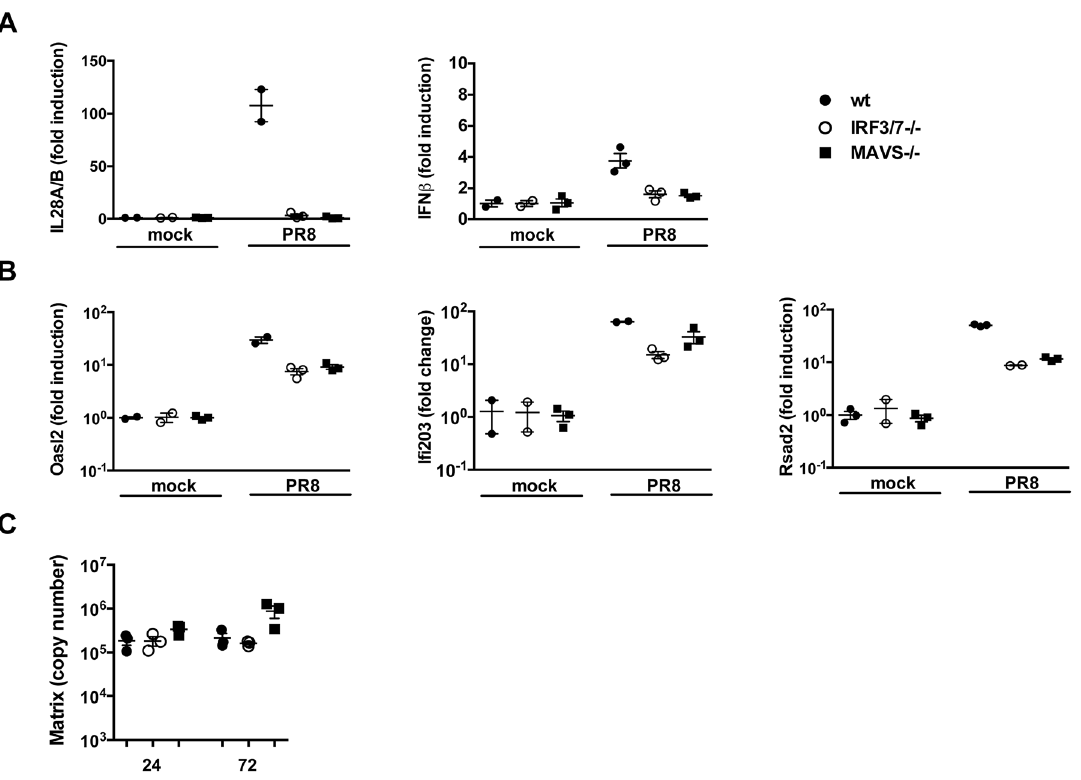
Figure 4. ISGs are induced in the absence of detectable type I and III IFNs. Wild-type, MAVS 2 / 2 and IRF3 2 / 2 IRF7 2 / 2 MTEC were either mock infected or infected with PR8 and their RNA analyzed 24 hpi for the induction of (A) both IFNs (IL-28A/B and IFN b ) and (B) ISGs (Oasl2, Ifi203, Rsad2). All the transcripts were first normalized to HPRT levels and then expressed as fold induction relative to the mean of mock infected controls, + / 2 SEM. (C) Viral replication was measured by qRT-PCR on the Influenza A Matrix gene and expressed as copy number + / 2